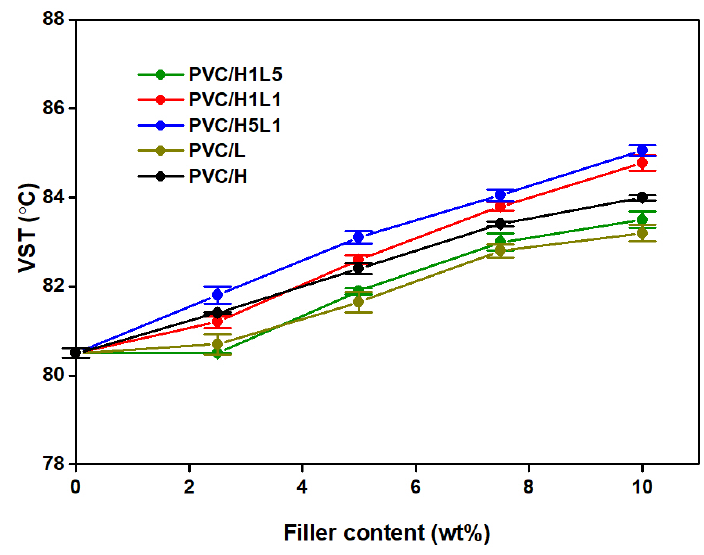
Figure 7. The Vicat softening temperature of PVC and PVC-based composites vs. filler content.